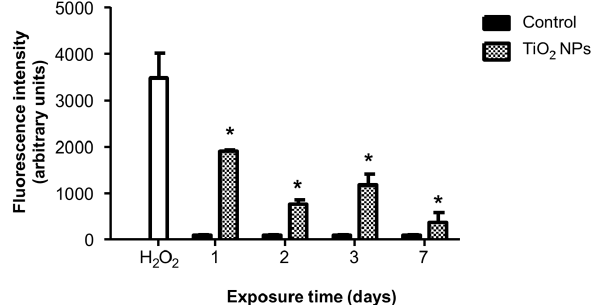
Figure 3. TiO 2 NPs treatment changed cellular redox state. H9c2 cells were treated with TiO 2 NPs (20 μ g/cm 2 ) alone for 1, 2, 3, and 7 days and cellular redox state was evaluated by H 2 DCFDA oxidation. Cells treated with H 2 O 2 (500 μ M) for 1 day were used as positive controls. Results were expressed as fluorescence intensity in arbitrary units and as mean ± standard deviation (SD) of three independent experiments ( n = 15). * Significant difference between control (untreated) and treated cells ( p < 0.05).